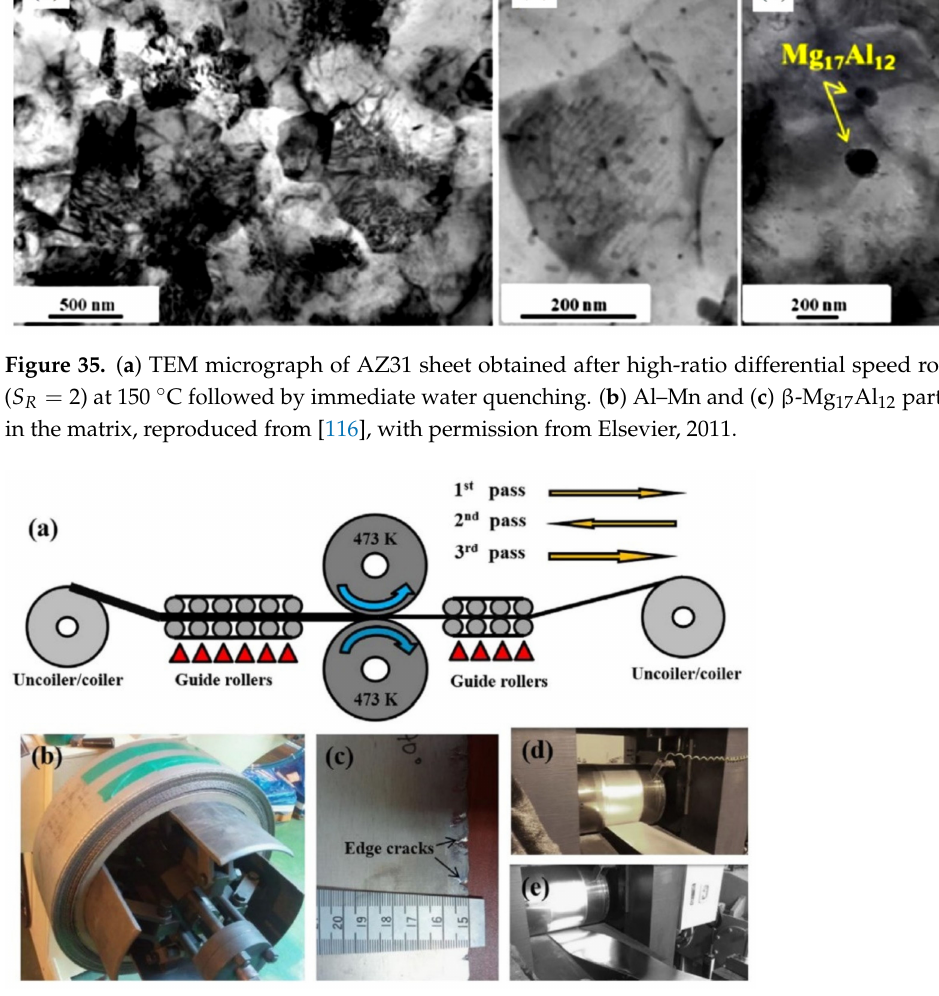
Figure 36. ( a ) The layout of the continuous HRDSR mill. ( b ) The appearance of the HRDSR-processed sheets in coil form. ( c ) The appearance of the HRDSR-processed sheets. Snap shots of the sheets coming out of the rollers during the second pass under ( d ) HRDSR and ( e ) conventional rolling conditions, reproduced from [117], with permission from Elsevier,